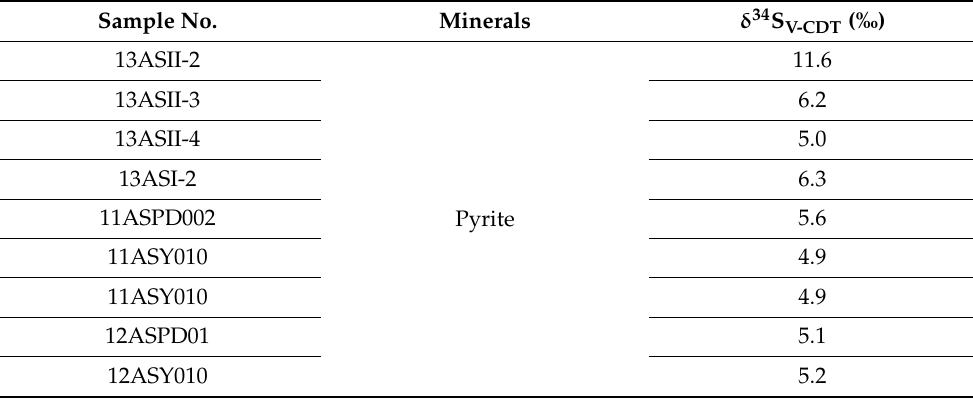
Table 4. Sulfur isotopic compositions of pyrite.